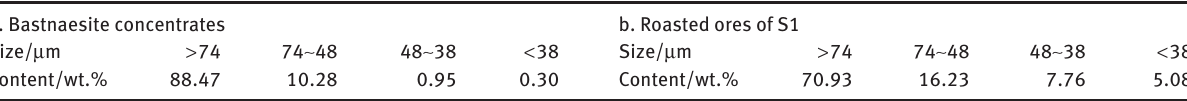
Table 3: Mineral particle size